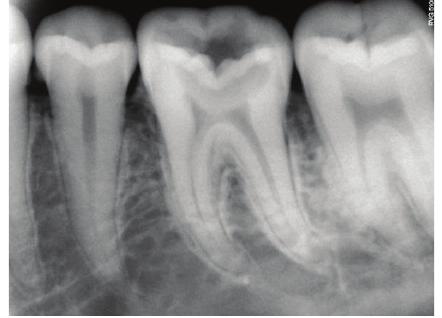
Figure 7: Preoperative